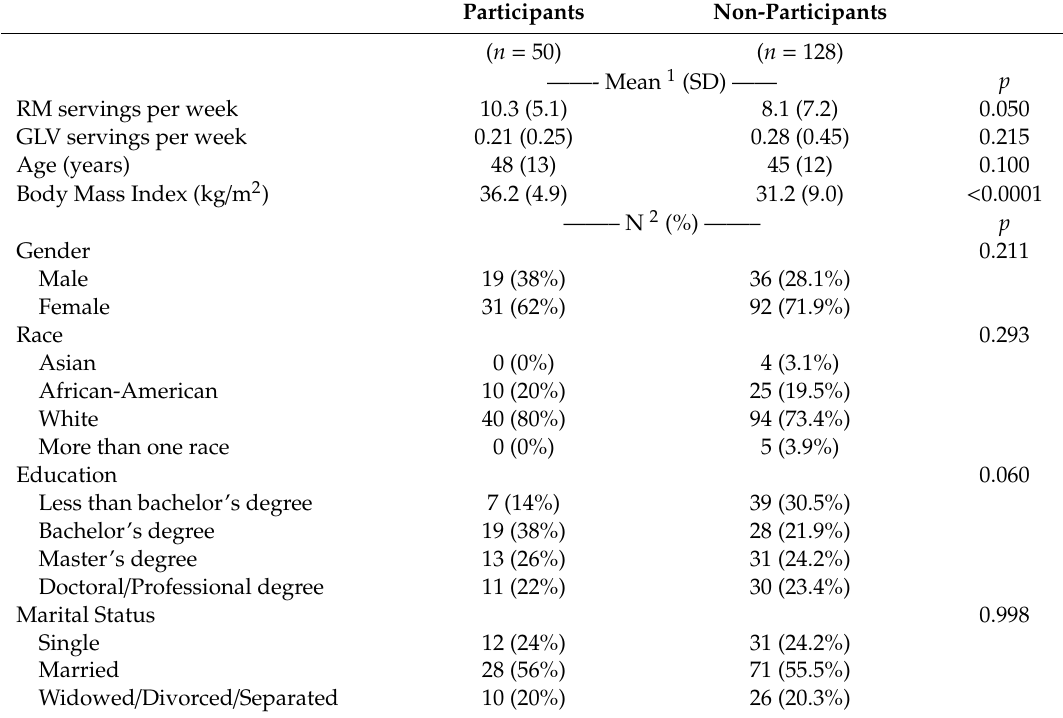
Table 2. Characteristics of participants and non-participants in a randomized controlled crossover high green leafy vegetable dietary intervention.